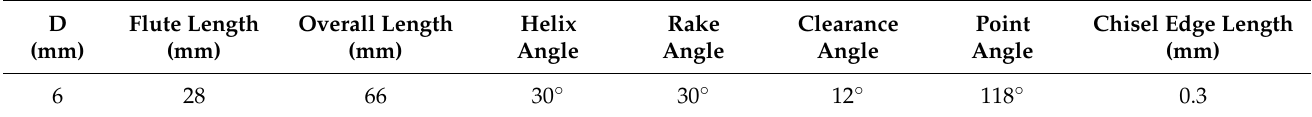
Table 3. Geometries of the cemented carbide